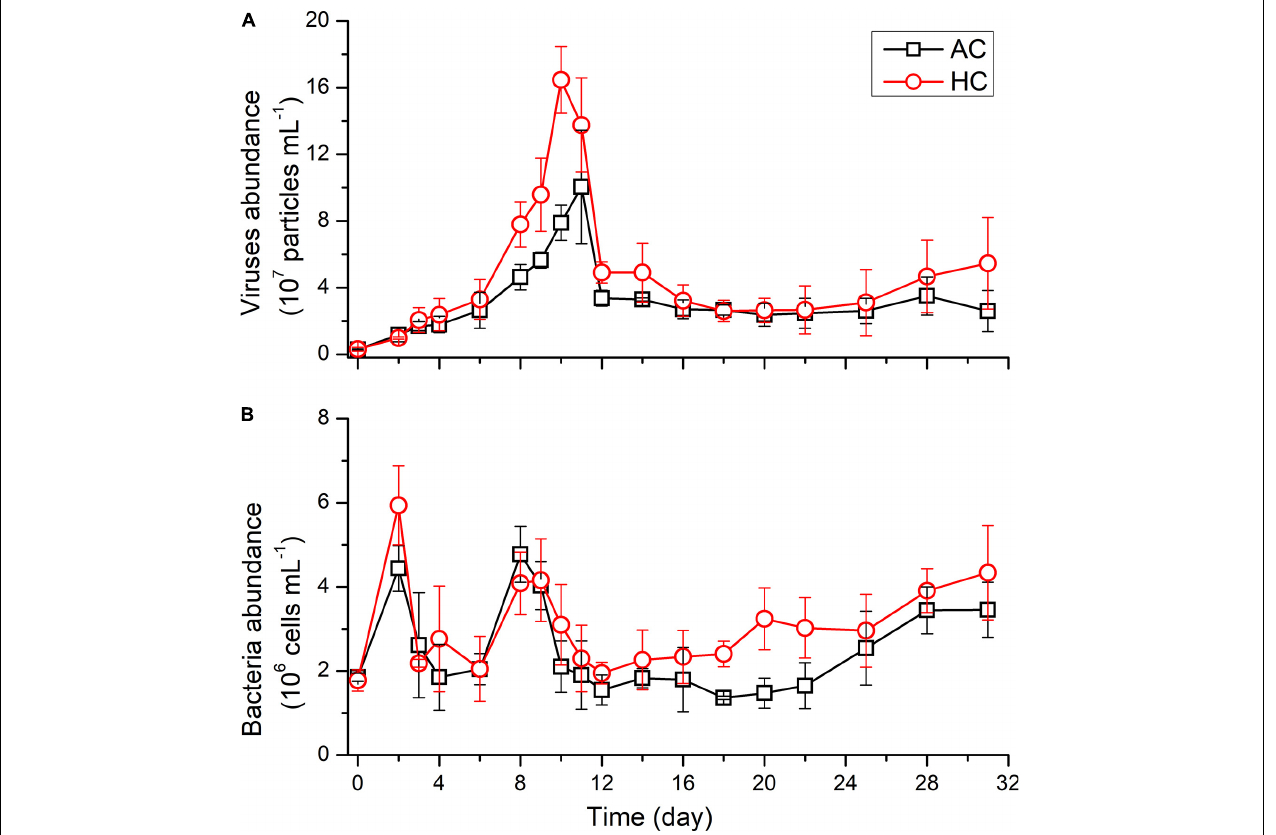
FIGURE 4 | Temporal variations of the abundance of viruses (A) and bacteria (B) in HC (1000 ppmv) and AC ( ∼ 410 ppmv) treatments. Data are means ± SD of replicates for HC treatments and for AC treatments.